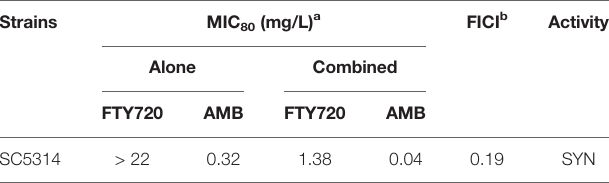
a FICI, fractional inhibitory concentration index b SYN, synergism; MIC 80 values and FICIs were calculated from three independent